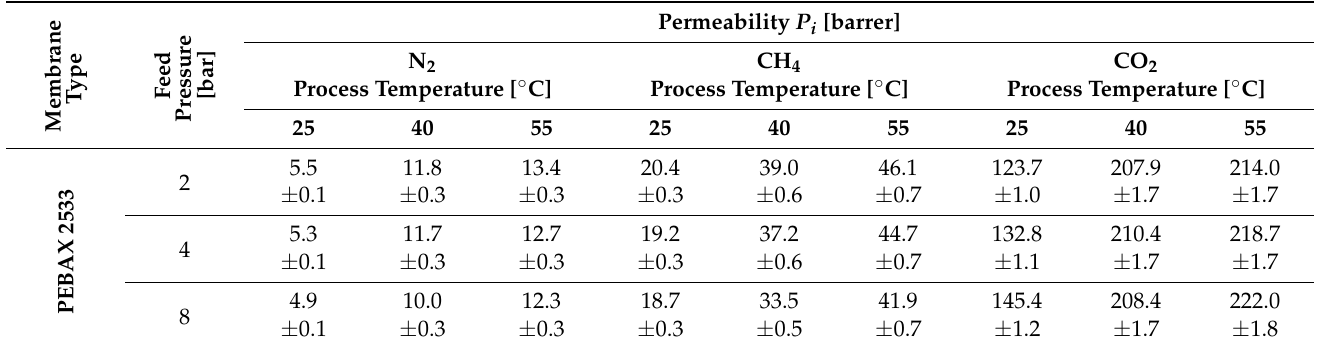
Table A1. Permeability of homogeneous membranes to different gases measured for different feed pressure and temperature values.